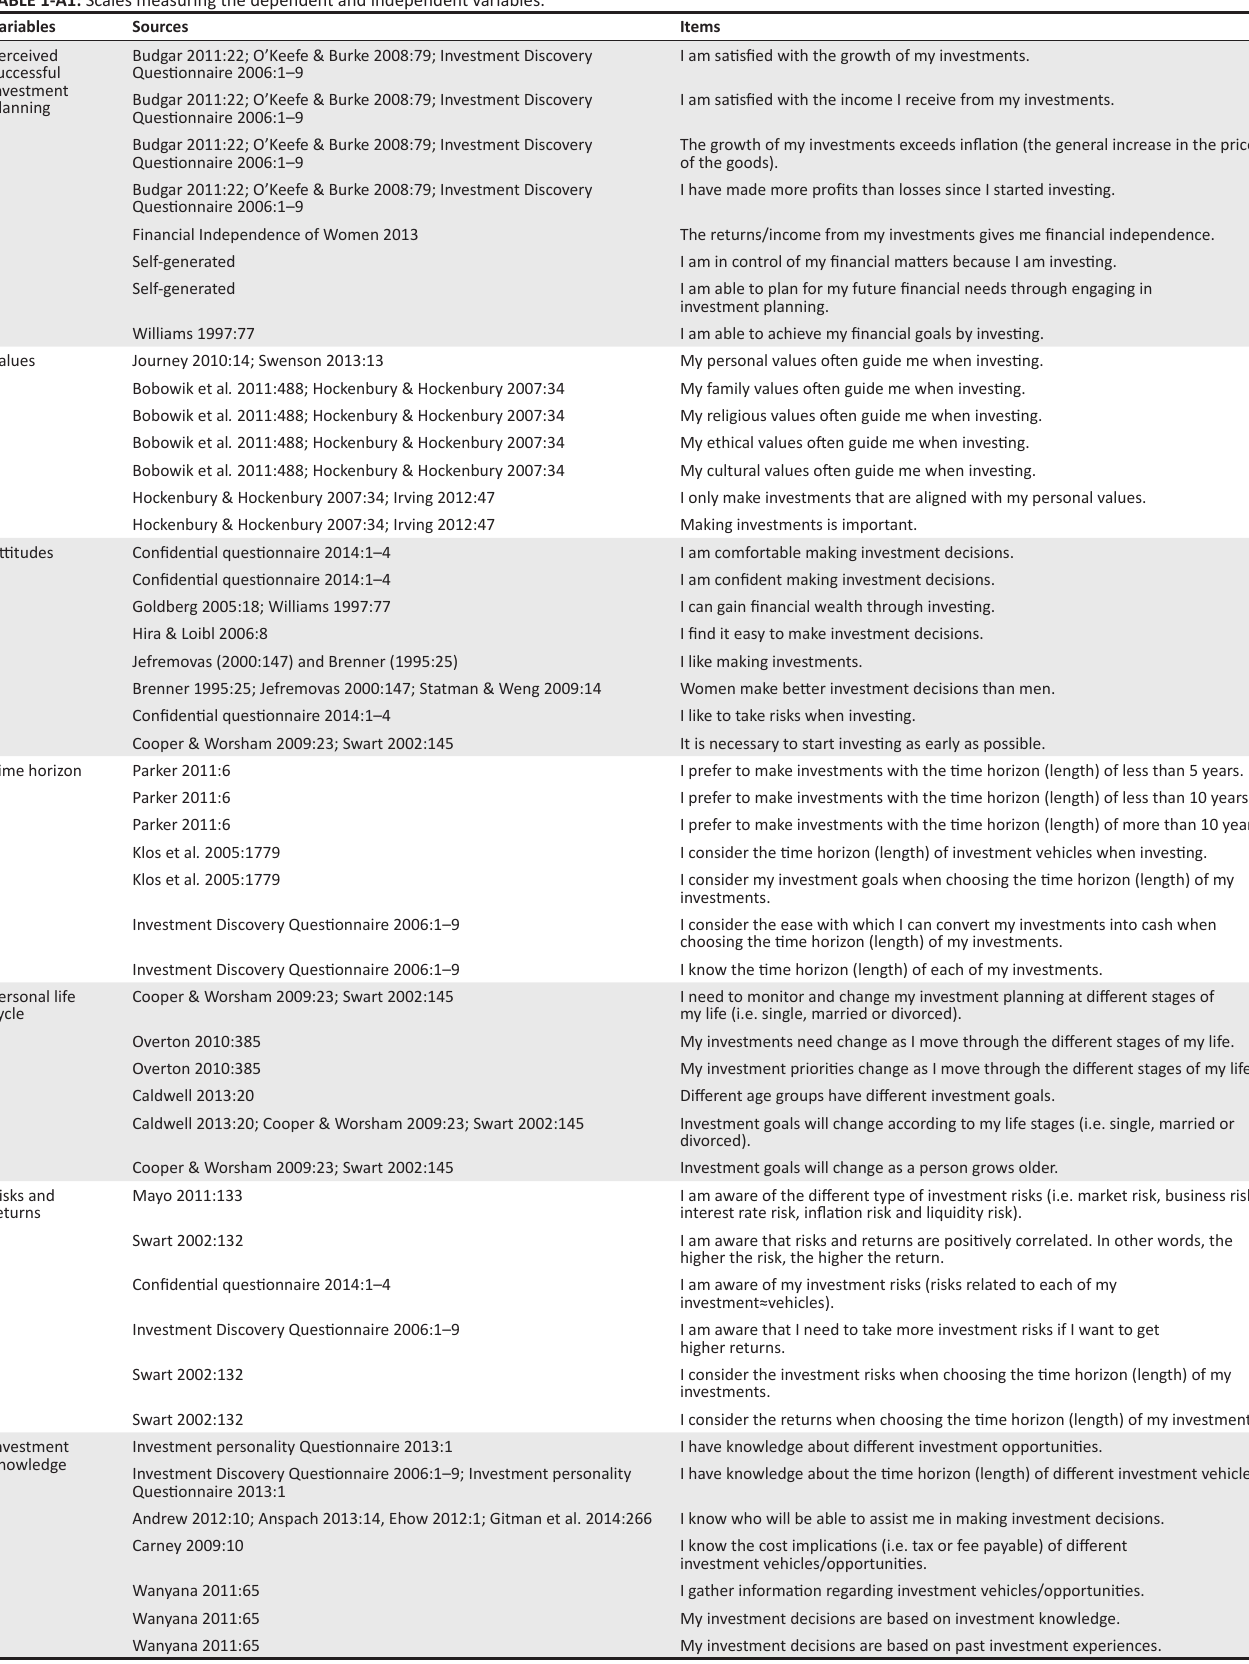
TABLE 1-A1: Scales measuring the dependent and independent variables.